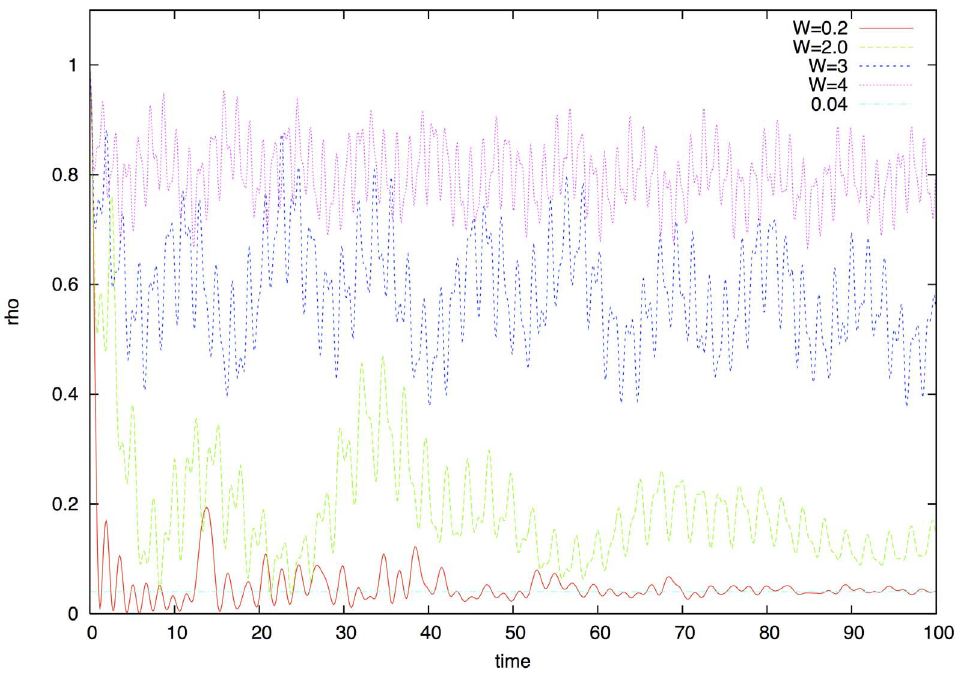
Figure 2. Probability that the exciton stays on the chromophore it started in represented by the density matrix element % 1,1 . Below the transition ( W ~ 0 : 1 ) coherence dies out quickly and the probability reaches its asymptotic value 1 = 25 . The peak at time & 13 is the result of the interference of waves going clock and anti-clockwise along the the circle and meeting again after turning around the structure. The rest of the structure comes from interference of waves scattering back from other chromophores. In the transition point and above coherent beats occur and the probability stays elevated for a very long time (not shown here). These are beats due to genuine quantum coherent superposition states.